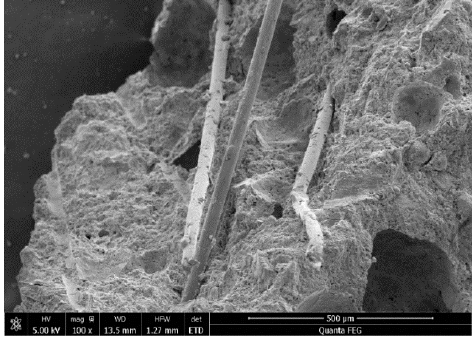
Figure 12. Microstructure of S3.